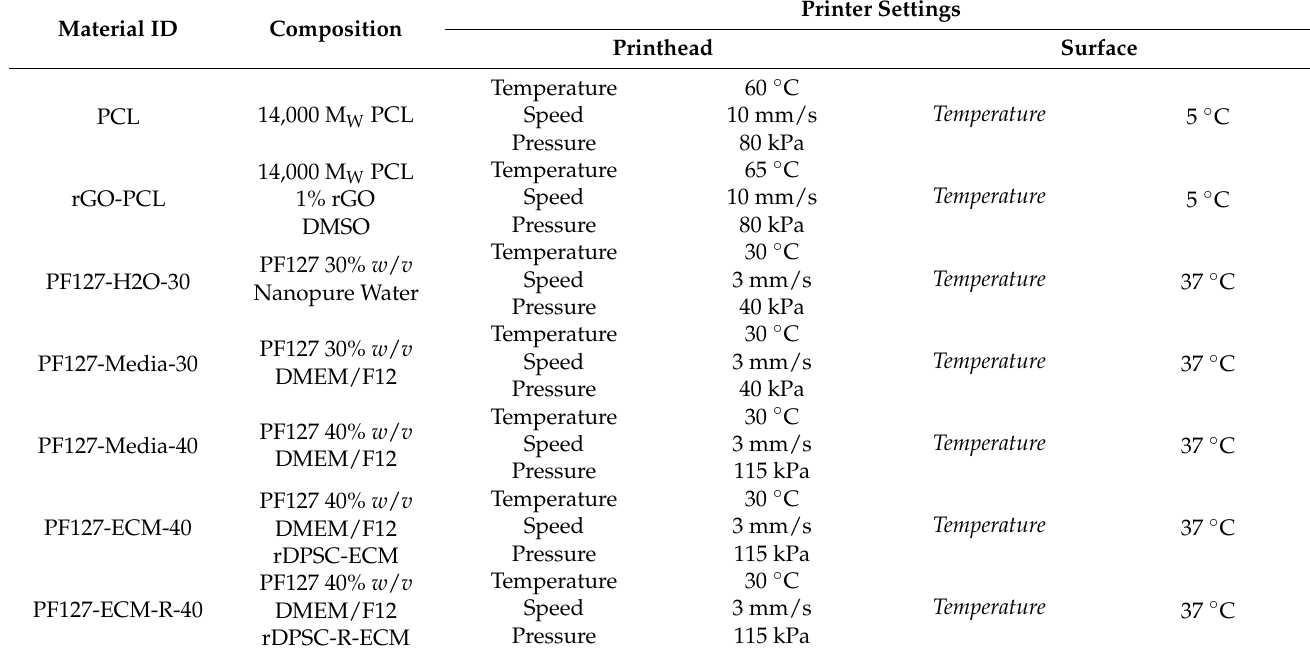
Table 3. Material identifiers, compositions, and print settings for fabricated biomaterials. Material